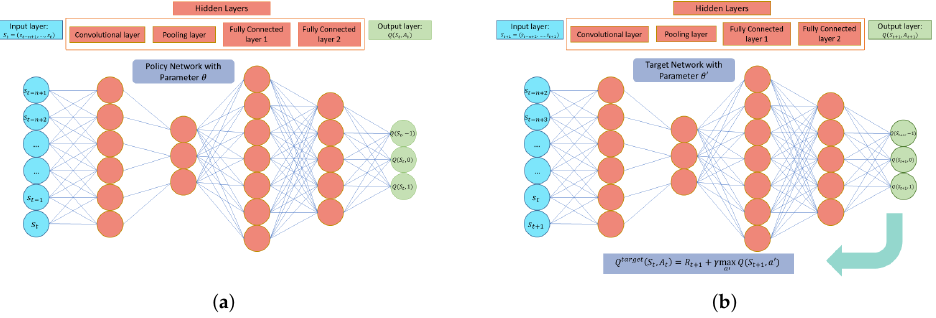
Figure 1. Convolutional deep Q-network diagram for quantitative trading. ( a ) The left policy network with parameters θ shows the first pass with the current state S t = ( s t − n + 1 , s t − n + 2 , . . . , s t ) as input to the network, and the network produces the Q values associated with short, neutral and long actions, respectively. ( b ) The right target network with parameters θ (cid:48) shows the second pass with the next state S t = ( s t − n + 2 , s t − n + 3 , . . . , s t + 1 ) as input, and the network outputs the state-action paired